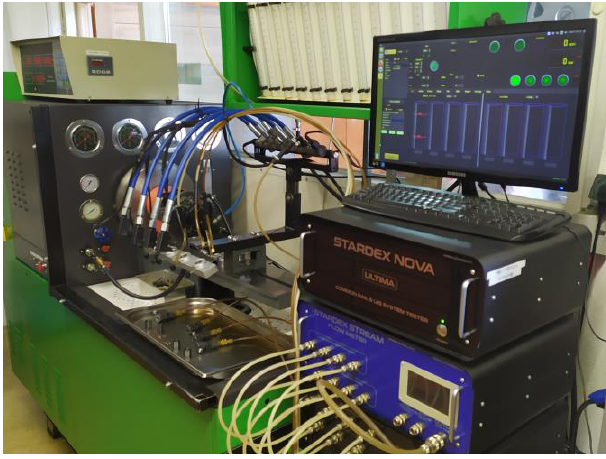
Fig. 2. 12PSB test bench with Stardex kit